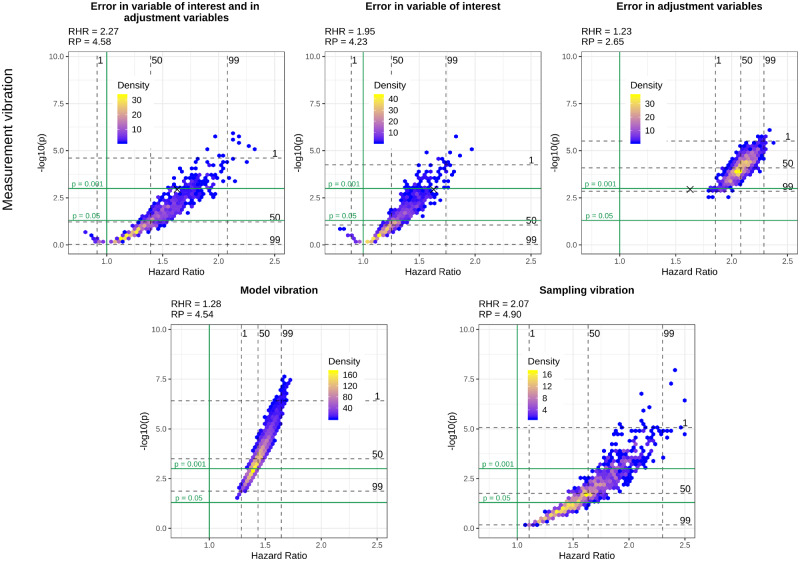
Volcano plots for different types of vibration and different scenarios of measurement vibration when diabetes is the variable of interest. The black cross in the top panel indicates the model without measurement error